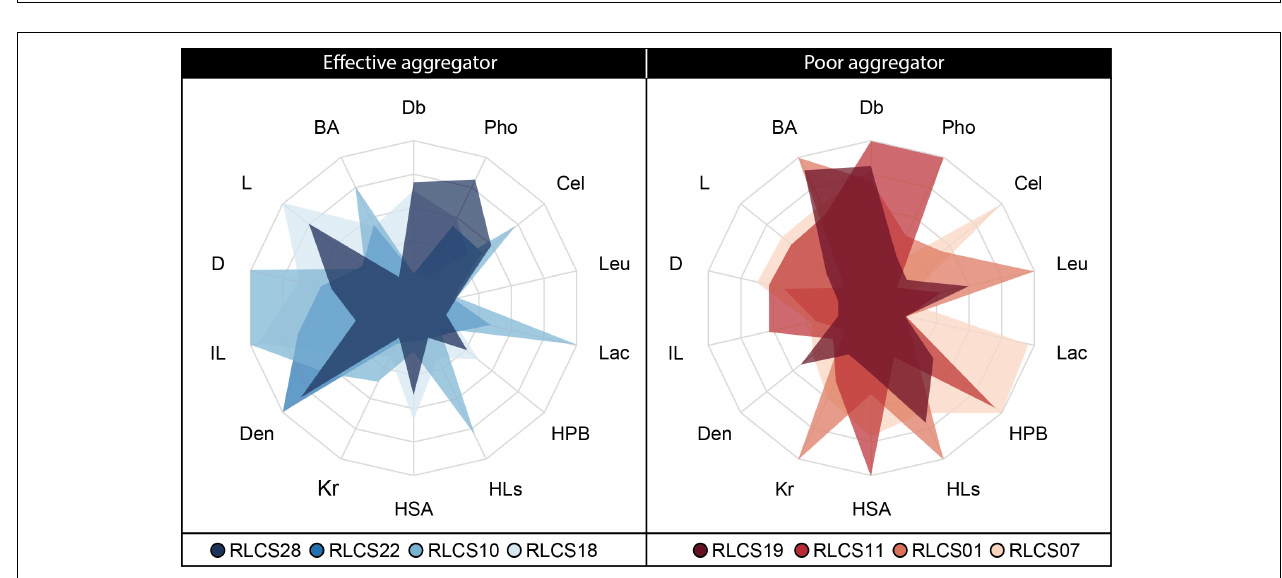
FIGURE 4 | Outcomes of principal components analysis, random forest analysis and relationships between soil aggregate formation (SAF) and important trait variables. Analyses were conducted on trait mean data ( n = 31). (A) Projection of the ordinated 31 fungal strains onto 15 trait variables comprising morphological, chemical and biotic characteristics into two dimensional trait space represented by principal component axis 1 and 2 (explaining 23 and 19% of variance, respectively). The trait variables are branching angle (BA), hyphal diameter (D), internodal length (IL), box counting dimension (Db), lacunarity (L), hyphal length in soil (HLs), hyphal surface area (HSA), biomass density (Den), radial colony extension rate (Kr), hydrophobicity of fungal surfaces (HPB), cellobiohydrolase (Cel), laccase (Lac), leucine aminopeptidase (Leu) and acid phosphatase (Pho) activity, and palatability (PT). Arrows indicate direction and weight of trait vectors. Red–white color gradient represents probability of species occurrence (white = low, red = high) in the trait space, with the contour lines denoting the 0.50, 0.95, and 0.99 quantiles of kernel density estimation (see “Materials and Methods” section). The dot outline represents phylum affiliation (black: Mucoromycota, gray: Basidiomycota, white: Ascomycota) while dot filling represents soil aggregate formation capability (SAF) of fungal strains (represented by a blue–red color gradient; red: low SAF, blue: high SAF). (B) Overall importance of trait variables for SAF capability with R 2 expl = 0.36, 0.13 and three statistically significant predictor variables. Asterisks denote significance level: ∗∗ < 0.001, ∗ < 0.01, < 0.5. Pairwise phylogenetic distance was included as PCo-axes (see “Materials and Methods” section). (C–E) Partial dependence plots for the three most important and significant trait variables identified by random forest approach. For phylogeny, we depicted PCo axis 1 on the x -axis representing the axis scores. The x -axis labels are identical with panels (F–H) , respectively. (F–H) Relationships between SAF and the three most important trait variables. Corresponding regression statistics can be found in Supplementary Table S5 . Phylum affiliation of fungal strains is color-coded (black: Mucoromycota, gray: Basidiomycota, white: Ascomycota). Red and blue lines represent linear and quantile regression lines, respectively. The line type depicts significance of regression lines with solid < 0.05 and dashed > 0.05. The trait database is available in Supplementary Table S6 .